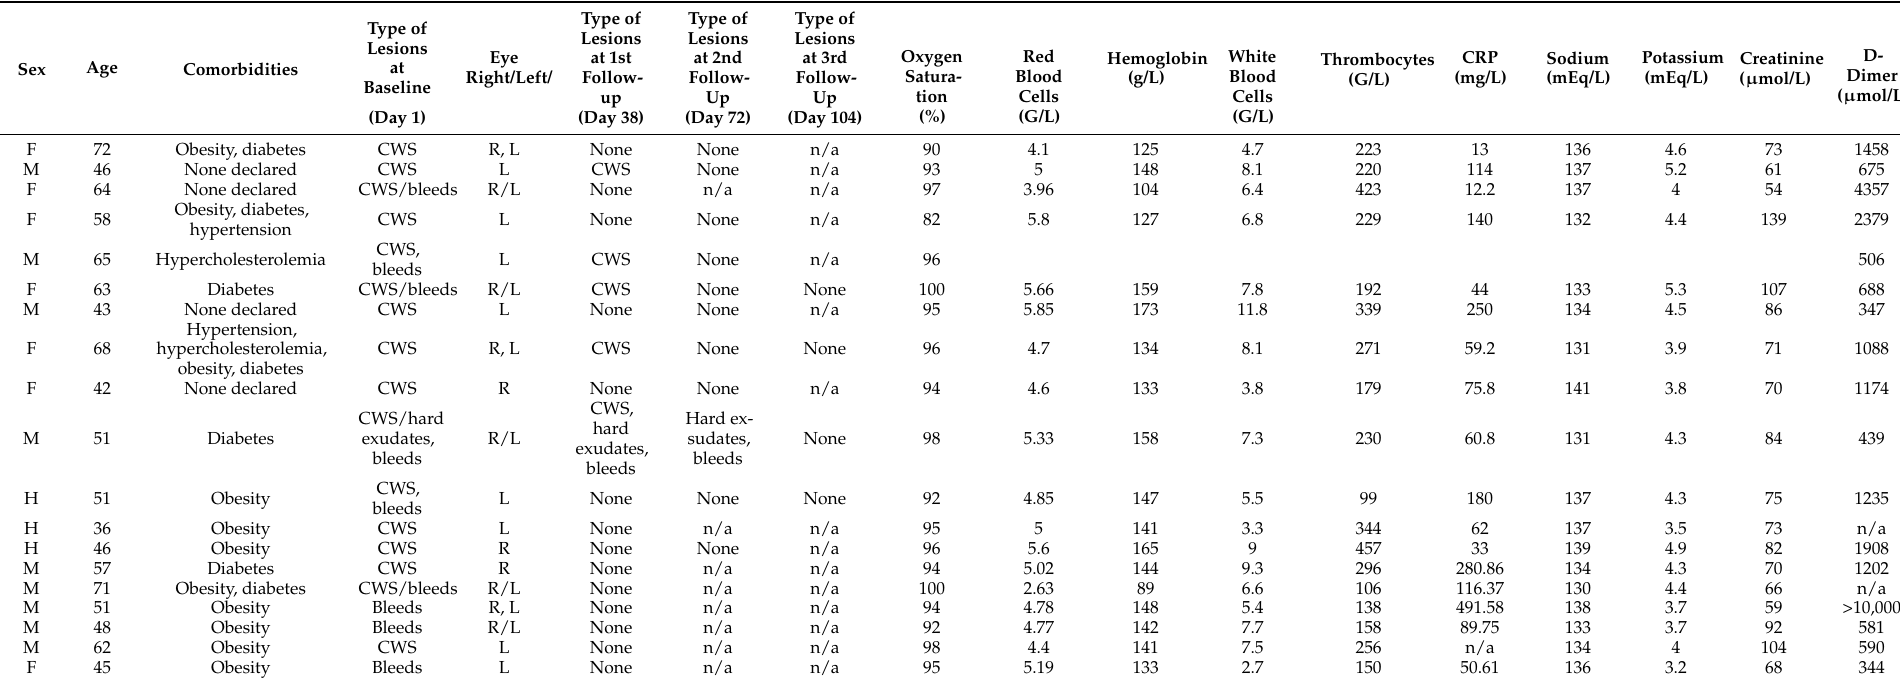
Table 2. Demographics, clinical features, and laboratory parameters of the 19 patients with observed retinal